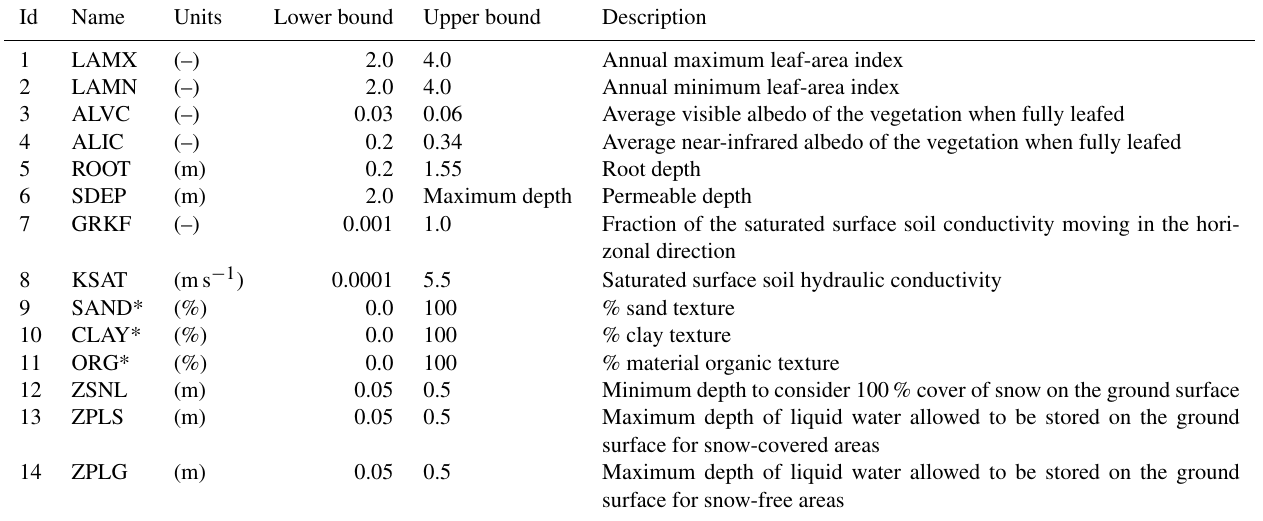
Table 2. List, description, and ranges of model parameters perturbed in this study. The values of soil texture parameters SAND, CLAY, and ORG (denoted by *) sampled such that they sum to 100%.